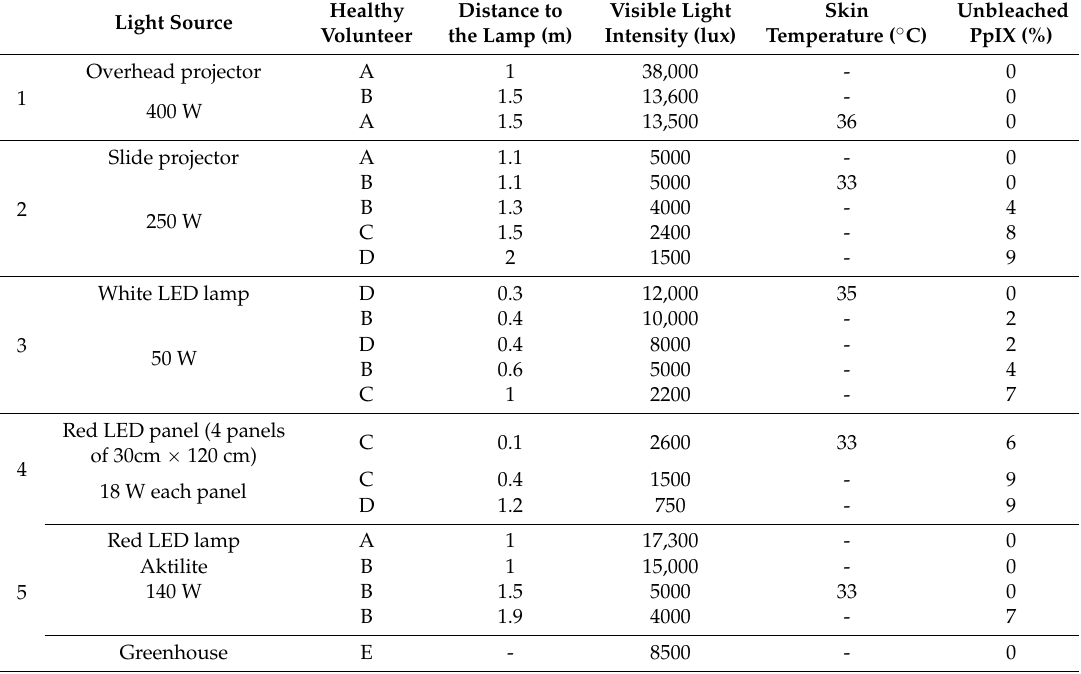
Table 2. Accumulation of PpIX during two hours of illumination with the different artificial “daylight” sources. Numbers 1 and 2 are both halogen light, while 4 and 5 are both red LED light (Figure 3). The skin temperature was 33 ˝ C before illumination in all volunteers. The skin temperature given in Table 2 was stable after 20 min of illumination. Distance to Visible Light Light Source the Lamp (m) Intensity